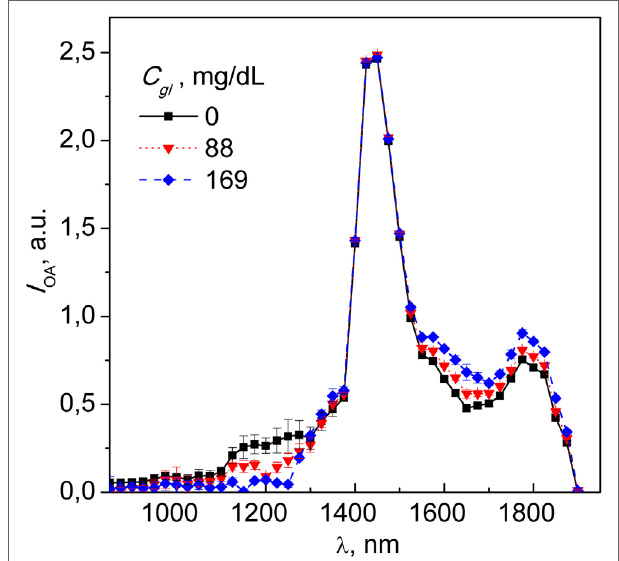
FIGURe 2 | Spectra of distilled water with subsequent glucose titrations at 88 and 169 mg/dl; each spectral point represents an average of five independent readouts, with error bars indicating the SD of the optoacoustic signal. Note the dose-dependence diversion of the spectra of glucose- containing analyte from that of DH 2